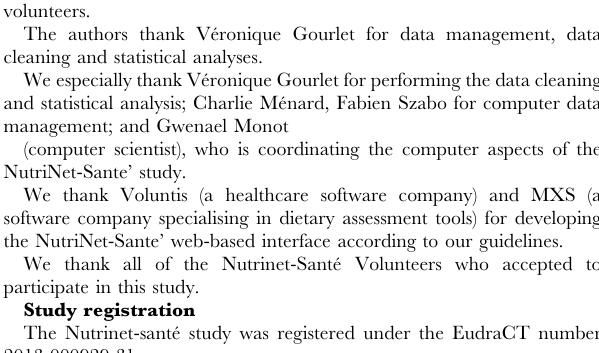
Table S2 Diet perception according to the type of diet followed – Cross-tabulations– Men (n= 2311). Table S3 Diet perception according to the type of diet performed – Cross-tabulations- Women (n= 18036). Table S4 Comparison between subjects having followed at least one weight loss diet in the past three years and subjects not having followed any; Analyses stratified by